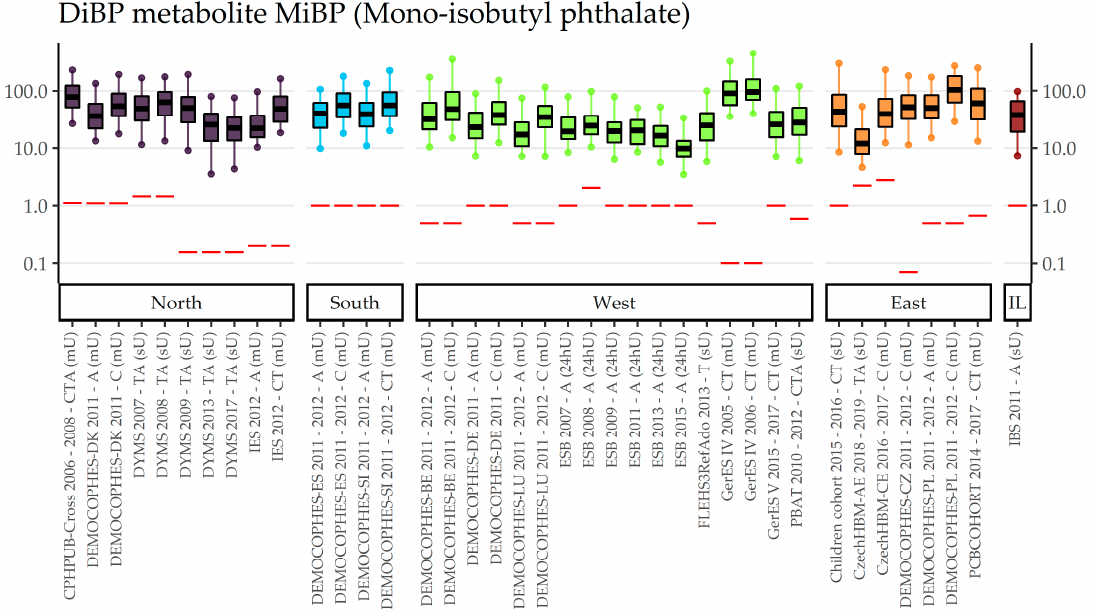
Figure 4. DiBP metabolite MiBP concentration in µ g/L in boxplots. The box is based on P25, P50, and P75, and the whiskers are based on P5 and P95. Boxplots are presented separate by regions (North = violet, South = blue, West = green, East = orange, Israel = dark red), within regions chronologically sorted by year of sampling. Red lines denote LOQ/LOD for the respective study. Since percentiles are only available and displayed when they are above LOQ/LOD, the lower side of boxplots might be truncated. The age categories are shown in capital letters: children of the age groups 3–5 and 6–11 (C), adolescents between 12 and 19 years (T) and adults from the age groups 20–39, 40–59 and 60 years and older (A). The sampling method is indicated in brackets: first morning urine void (mU), spot urine (sU) and 24-hours urine